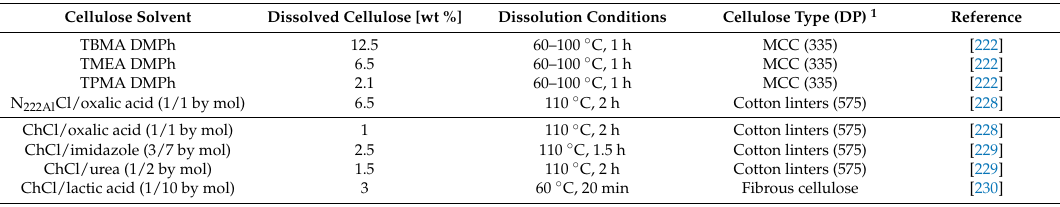
Table 5. Summary of the solubility of cellulose in QAE and